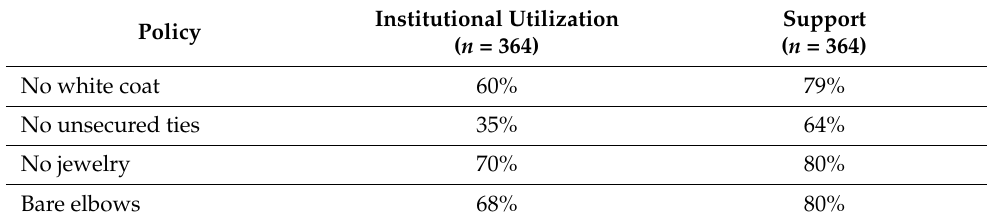
Table 6. Policies, Opinions and General Trends in Relation to